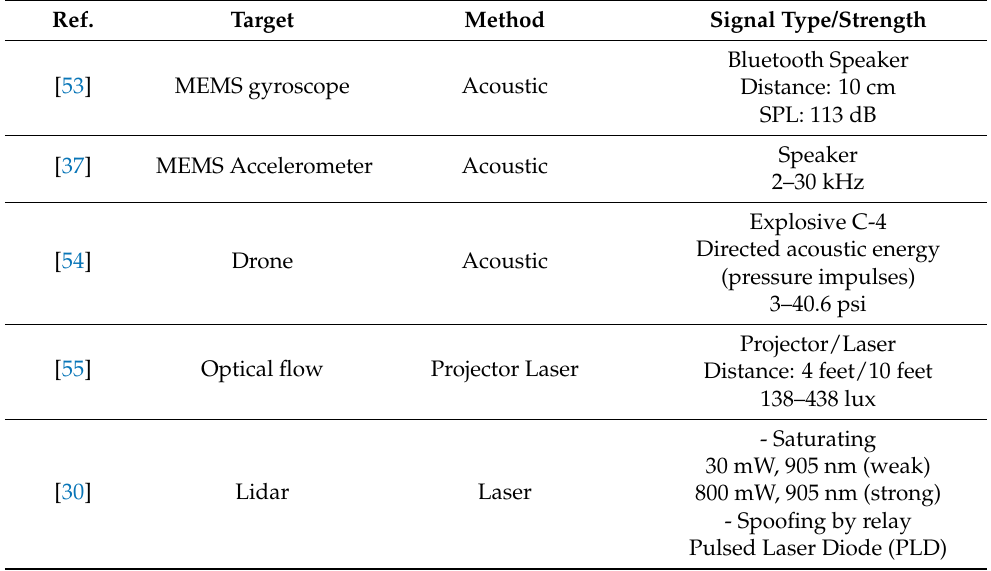
Table 4. Studies on Non-RF